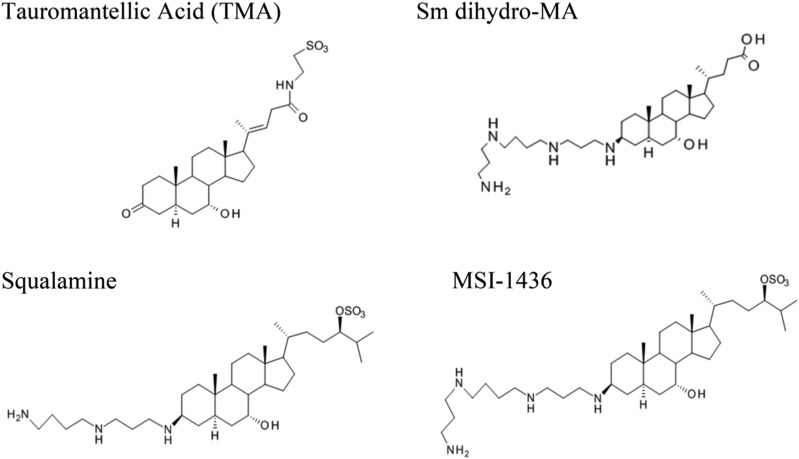
The structure of TMA, Sm dihydro-MA, squalamine, and MSI-1436 synthesized as described in Tessema et al. (2013). TMA was not synthesized for subsequent antimicrobial assays.